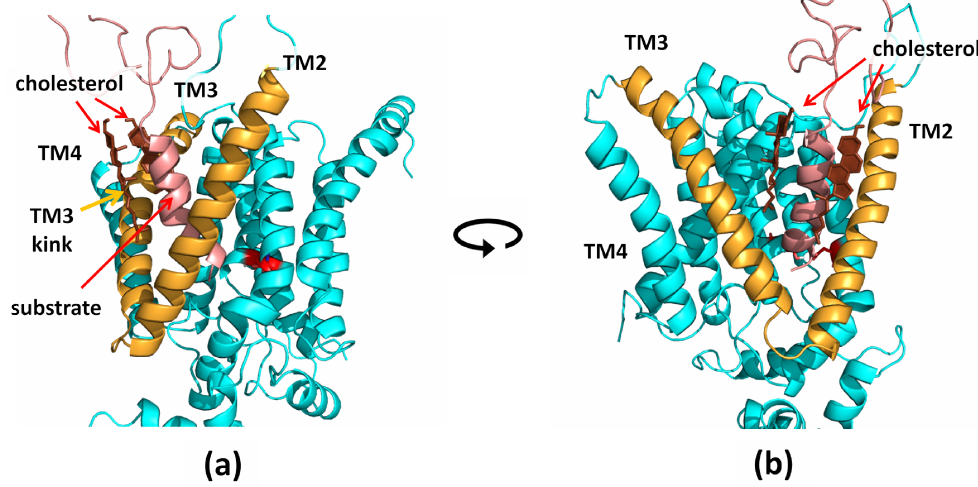
Figure 6. The presence of two cholesterol molecules (in brown) in the substrate binding site of PS-1 (in cyan) with extensive contacts with the substrate helix (in salmon) in the membrane with a high concentration of cholesterol. Helices TM2 and TM3 of PS-1, forming a triangle, are colored gold. The kink of TM3 is most visible in the left panel. The catalytic residues are shown in red. ( a ) Side view of the PS-1–substrate complex; ( b ) front view of the PS-1–substrate complex.